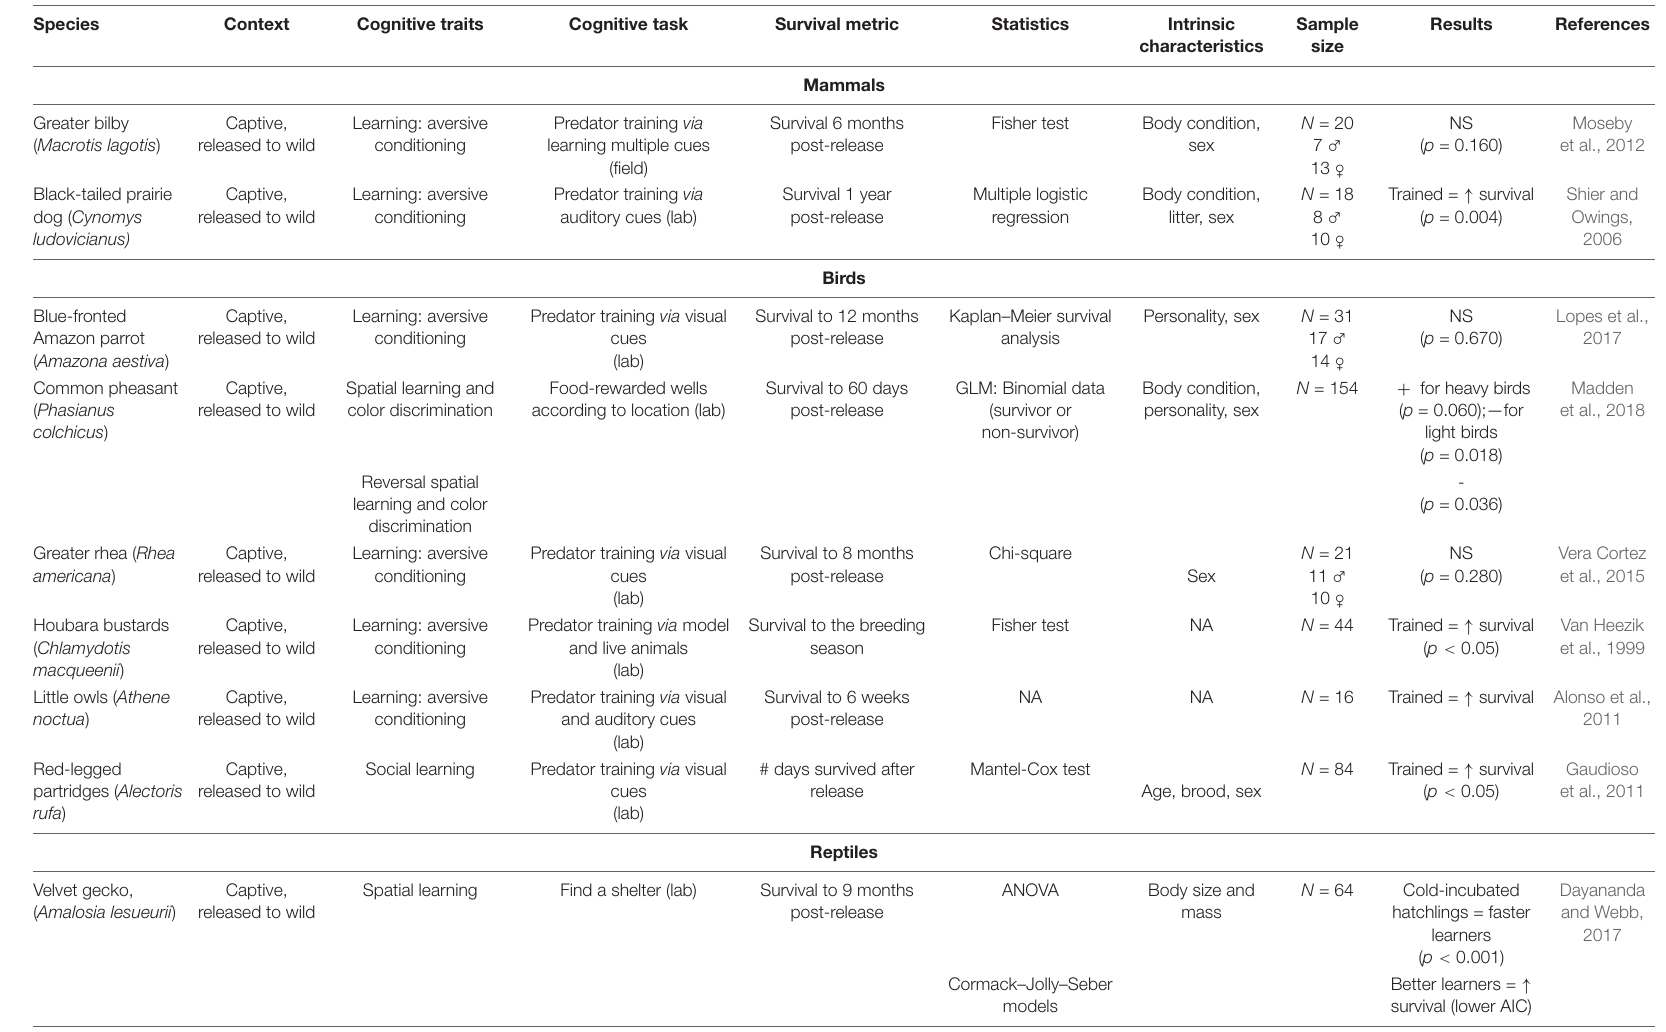
One study related problem-solving and spatial learning to survival, and eight studies related learning of predator cues to reintroduction success.